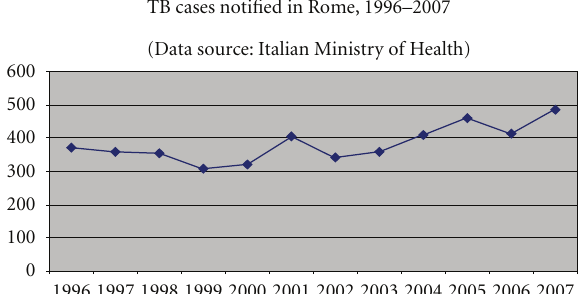
Figure 1: Linear diagram showing TB cases notified in Rome in the time-period 1996–2007 (source of the data: